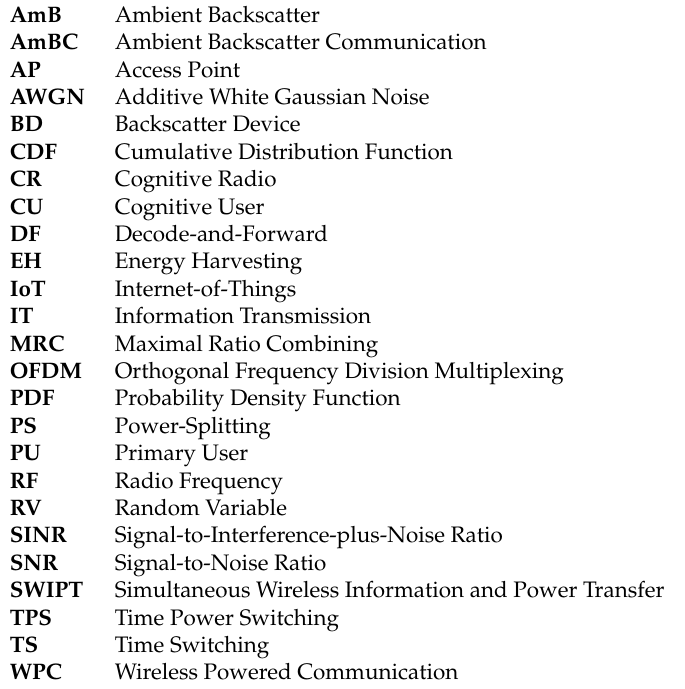
Table 1 provides all of the abbreviations and acronyms used in our paper. Table 1. Table of abbreviations and